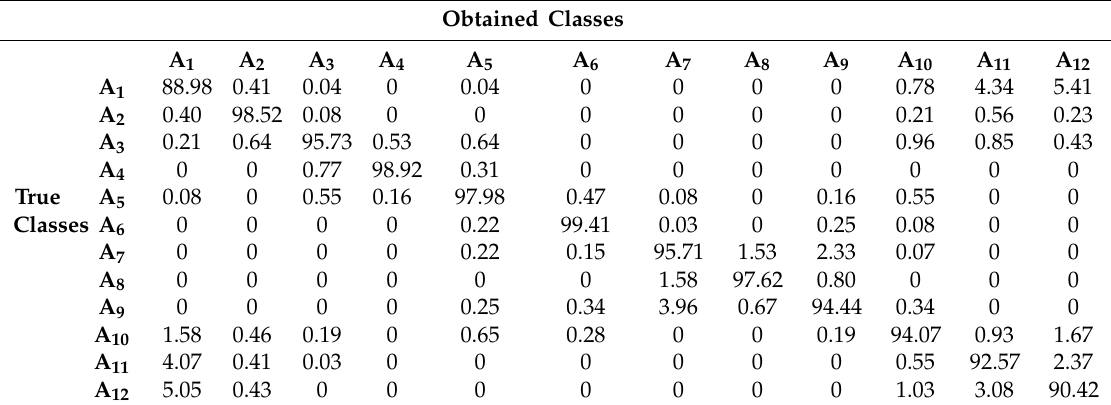
Table 5. Global confusion matrix obtained with k-NN using raw data. Obtained Classes